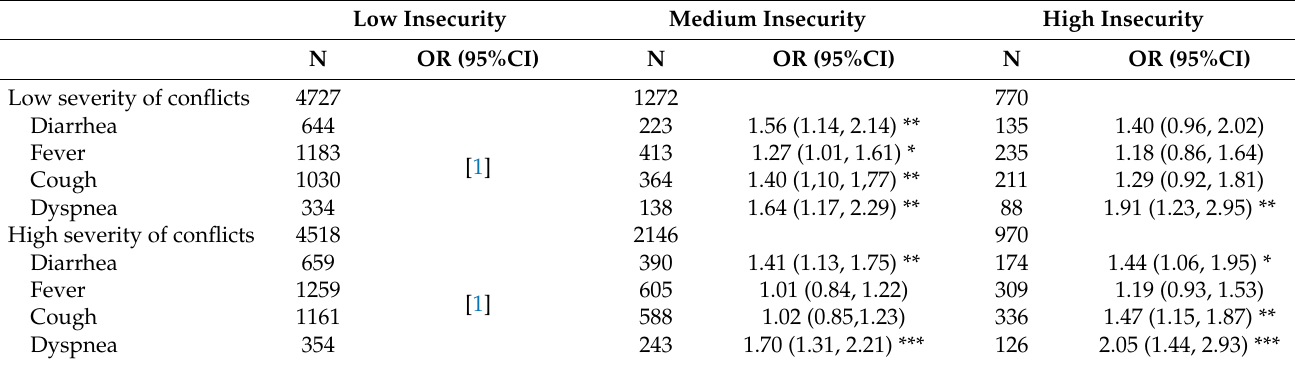
Table 7. Associations between self-reported insecurity with diseases in children, stratified by the severity of conflicts